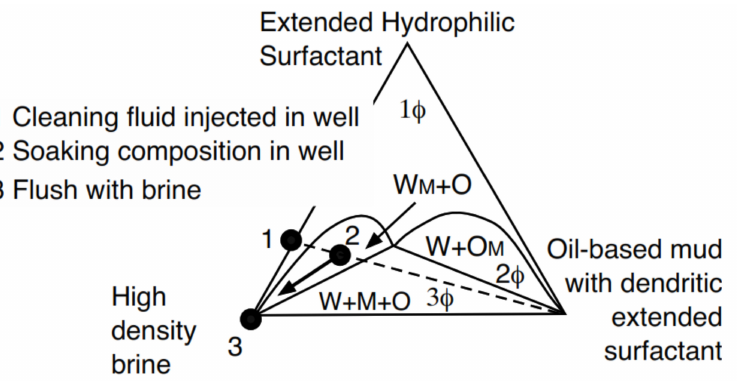
Figure 9. Cleaning process to remove the filter cake deposited during